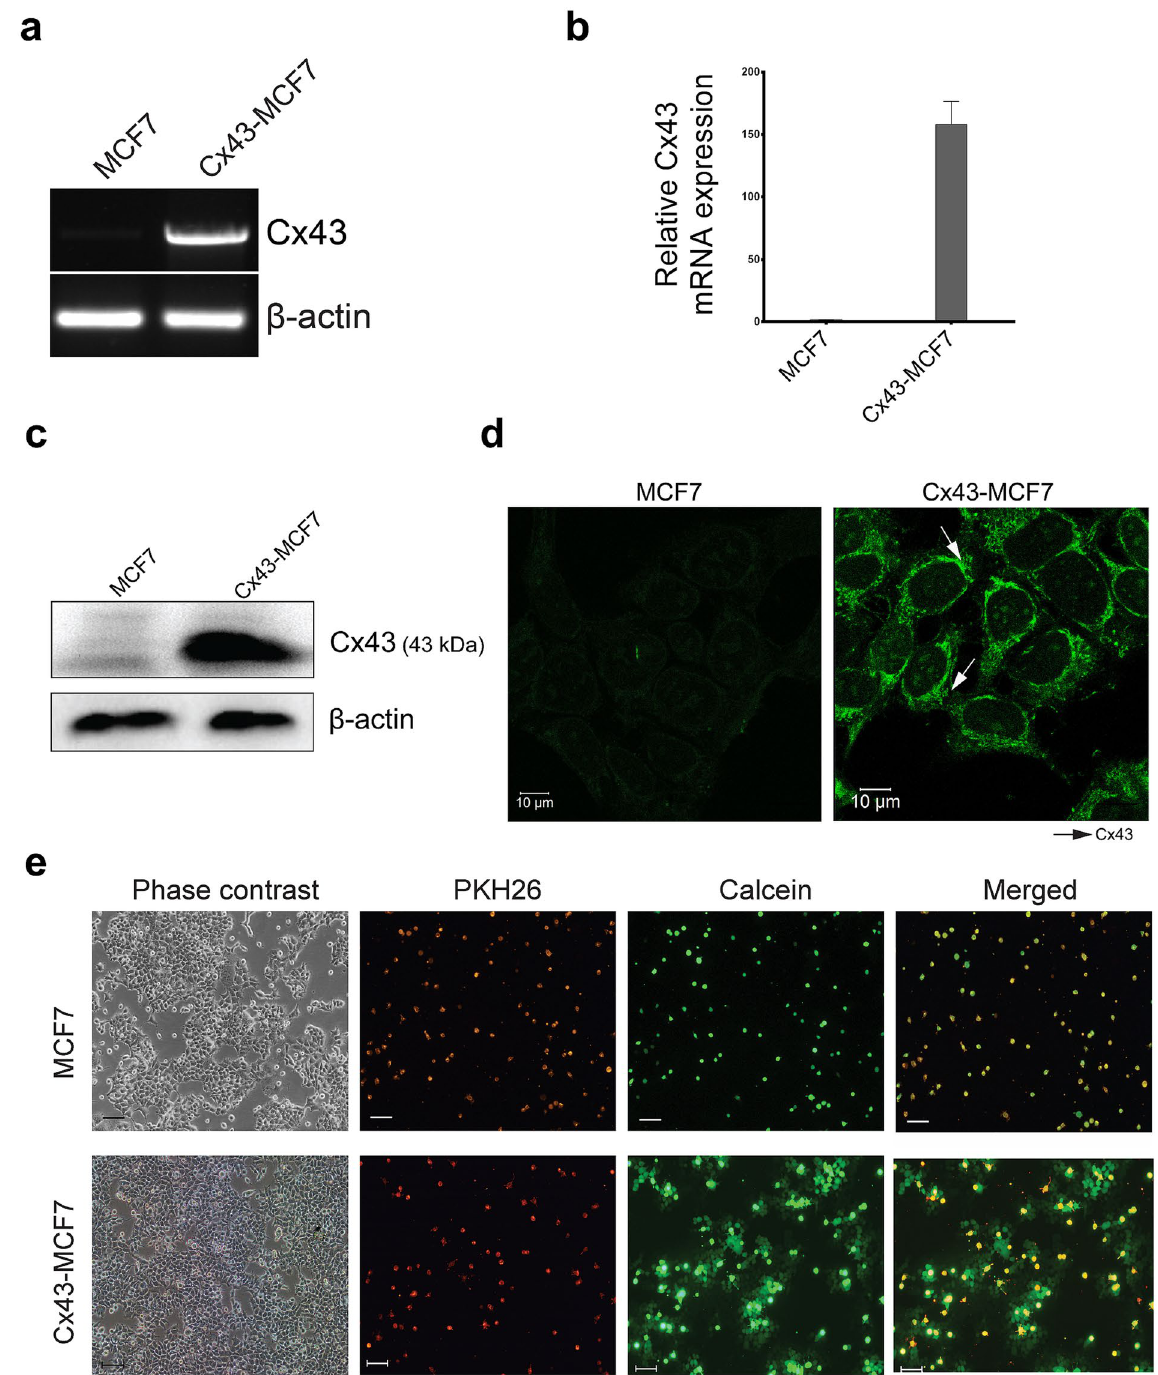
Figure 1. Cx43 overexpression and functional analysis of GJIC. ( a ) Expression level of Cx43 gene was initially examined by semi-quantitative PCR using cDNA library of MCF7 and Cx43 transfected MCF7 cells. The Cx43 gene band has been cropped and merged on top of the β -actin. ( b ) The comparative analysis of Cx43 mRNA expression in MCF7 and Cx43-MCF7 cells were analysed by using real-time PCR. The Cx43 mRNA expression in MCF7 cells was normalised to 1. ( c ) The Cx43 protein formation was then assessed by immunoblotting using anti-Cx43 antibody taking β -actin as endogenous control. ( d ) Represents the immunocytochemical analysis of Cx43 proteins in Cx43 transfected MCF7 cells revealed its presence at cell-cell contact points (arrows) and also in lesser extent inside cytoplasm. Bar = 10 µ m. ( e ) Functionality of GJIC was determined by dye transfer assay using two different fluorescent probes viz. PKH26 and calcein AM. Bar = 100 µ